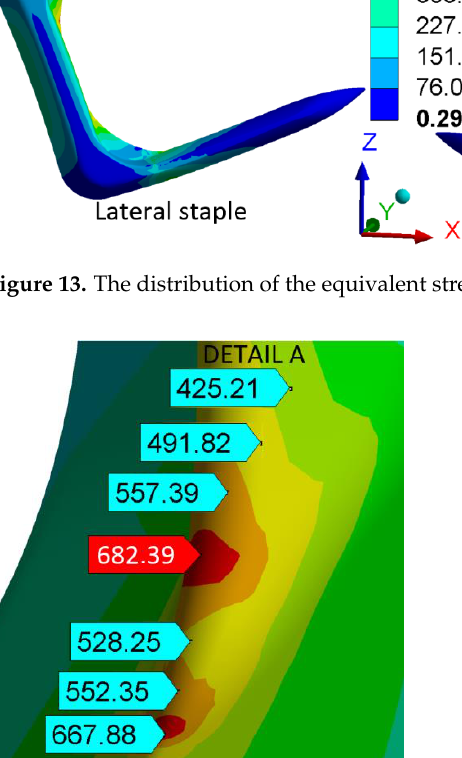
Figure 13. The distribution of the equivalent stress (von Mises) in the staples (MPa).